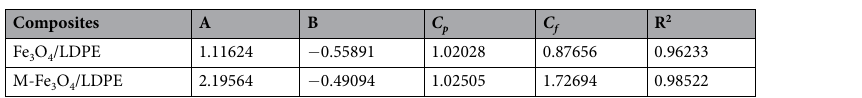
Table 2. Values of C p and C f for the Fe 3 O 4 /LDPE and M-Fe 3 O 4 /LDPE